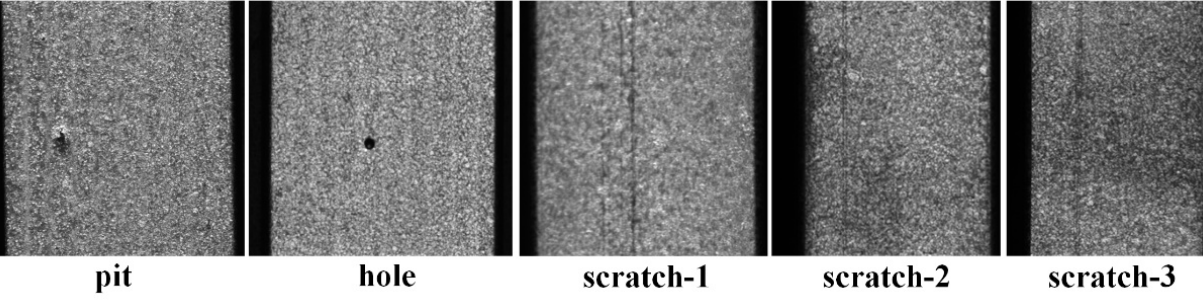
Figure 2. Examples of surface defects.